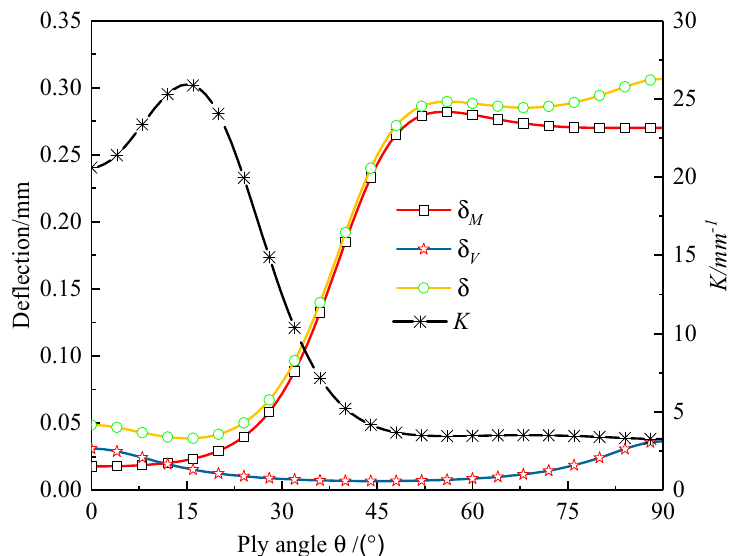
Figure 21. Deflection δ and stiffness coefficient K of composite aluminum honeycomb sandwich laminated box beam changing with the ply angle.